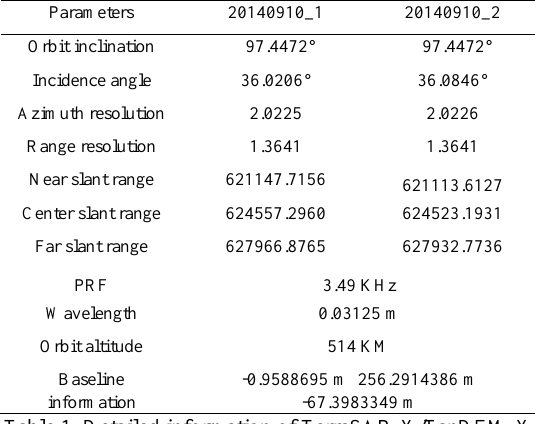
Table 1. Detailed information of TerraSAR-X/TanDEM-X